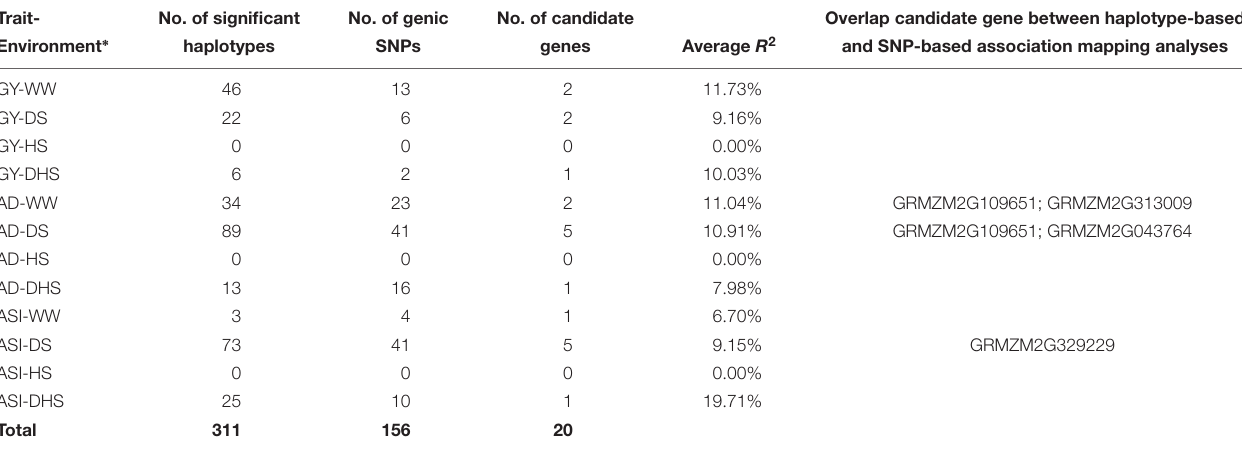
TABLE 2 | The haplotype-based genome-wide association mapping results of the 12 trait-environment combinations in the DTMA panel. Trait- No. of significant No. of genic No. of candidate Overlap candidate gene between haplotype-based